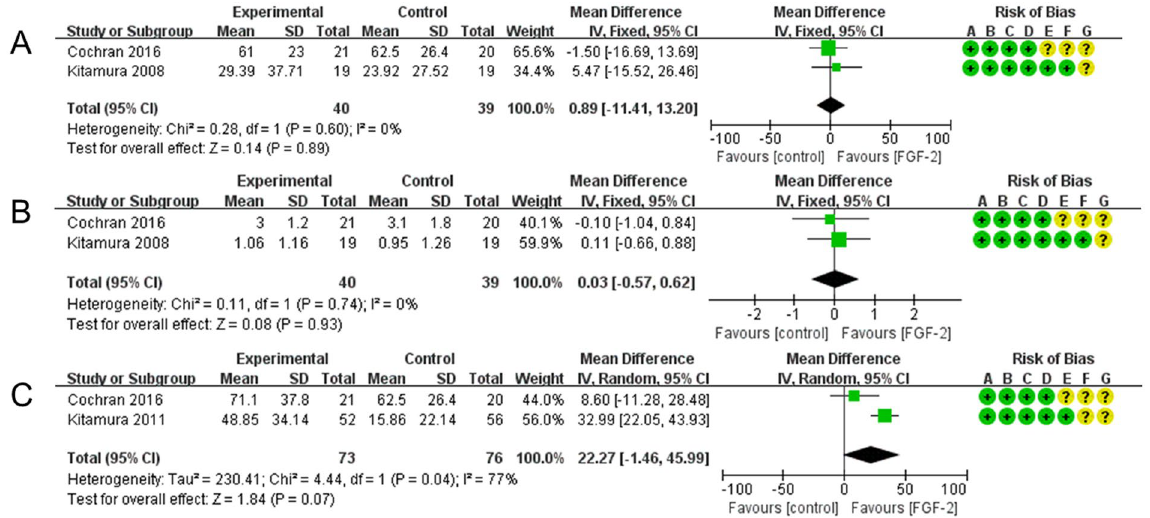
Figure 2. ( A ) Forest plot of comparison: 0.1% FGF2 groups was compared with control groups among patients with osseous defects, outcome: BF%. ( B ) Forest plot of comparison: 0.1% FGF2 groups was compared with control groups among patients with osseous defects, outcome: LBG. ( C ) Forest plot of comparison: 0.4% FGF2 groups was compared with control groups among patients with osseous defects, outcome: